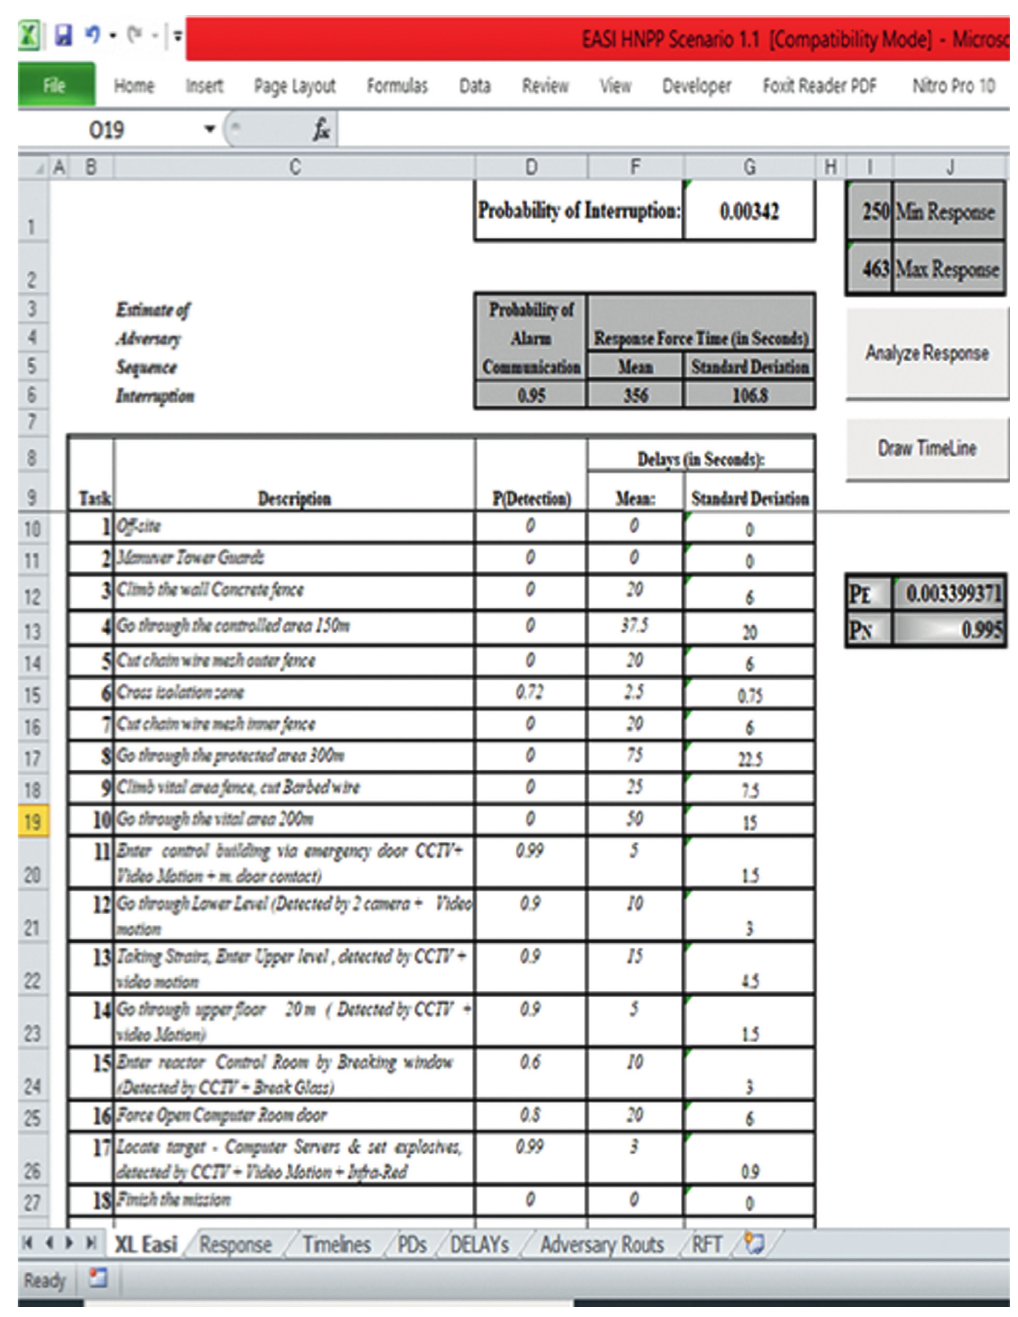
Figure 7: Attack path action sequence and EASI calculations of P not